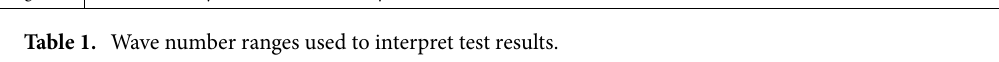
Table 1. Wave number ranges used to interpret test